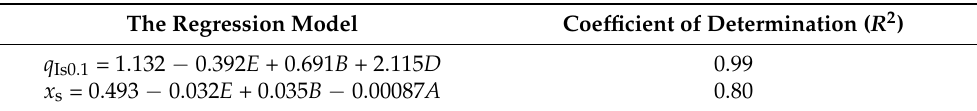
Table 6. Multiple linear regression model for the hydraulic performance of flow rate at H = 0.1 MPa ( q Is0.1 ) and flow index ( x s ) with structural